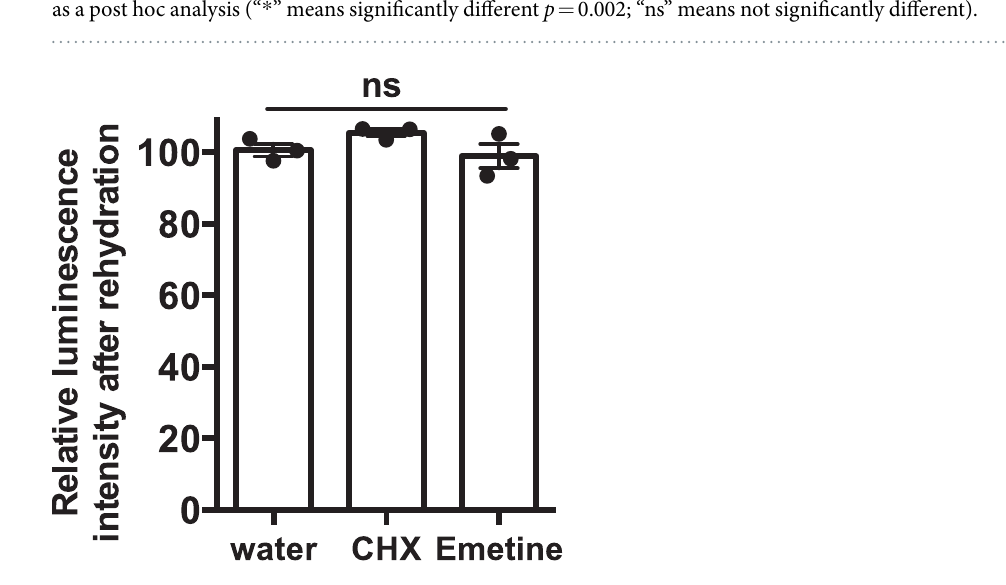
Figure 6. The de novo synthesis of luciferase after rehydration. Translation inhibitors cycloheximide (CHX, 0.35 mM) and emetine (1 mM), were added in the rehydration medium of dried Pv11-Luc cells. Luciferase activity was measured at 1 h after rehydration. Each value is shown as a scatter dot plot. Error bars show standard error of mean (n = 3). Statistical analyses were performed by using one-way ANOVA ( p = 0.19). The effective concentration range of inhibitors for Pv11 cells was determined using the transient gene expression system (Fig.